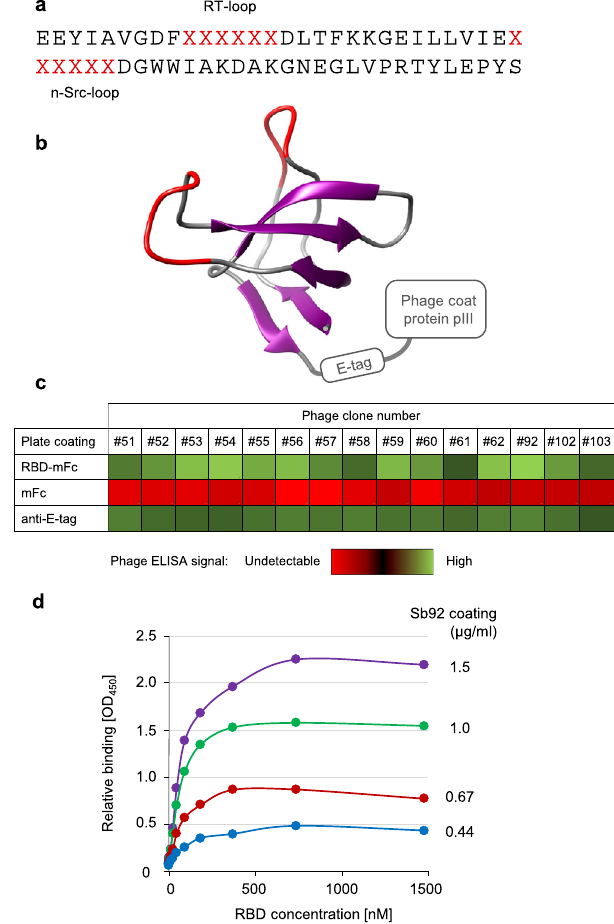
Fig.1|DiscoveryofRBD-targetingsherpabodies.a , b Sixandthreeresiduesinthe RT- and n-Src-loops, respectively, of the human nephrocystin SH3 domain were replaced with hexapeptides (in red) comprising random combinations of the 20 naturalaminoacidstocreatealargesemisyntheticM13phagelibrarydisplaying~10 11 individual sherpabodies with unique binding surfaces formed by the 12 randomized loop residues shown red in the illustration based on the structure pdb 1S1N (https:// www.ncbi.nlm.nih.gov/Structure/pdb/1S1N) 13 . c Heatmapshowingrelativebindingin an ELISA assay of fi fteen af fi nity-selected sherpabody-displaying phage clones tar- geted to RBD of SARS-CoV-2 spike protein (RBD-mFc), negative control (mFc), or an antibody evenly recognizing all displayed clones (anti-E-tag). d Semi-quantitative ELISA-based analysis of the RBD-binding af fi nity (30nM) of the sherpabody